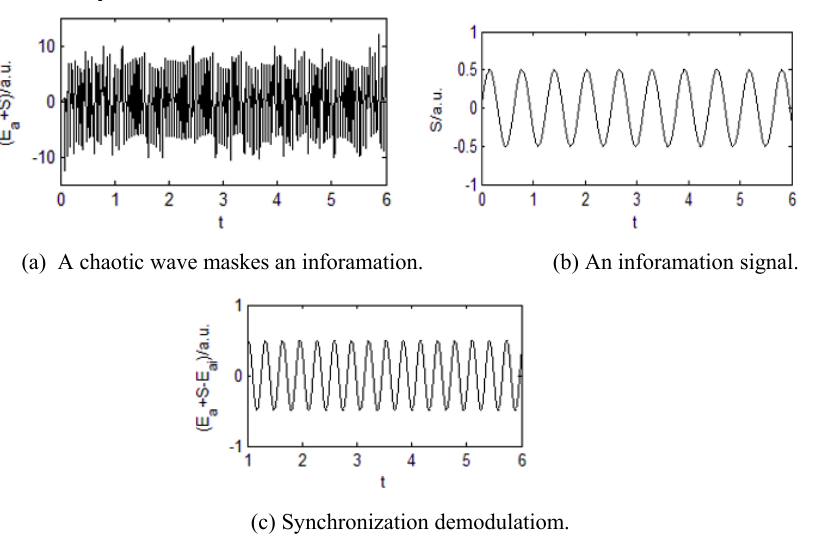
Fig. 4. Chaotic coding for secure